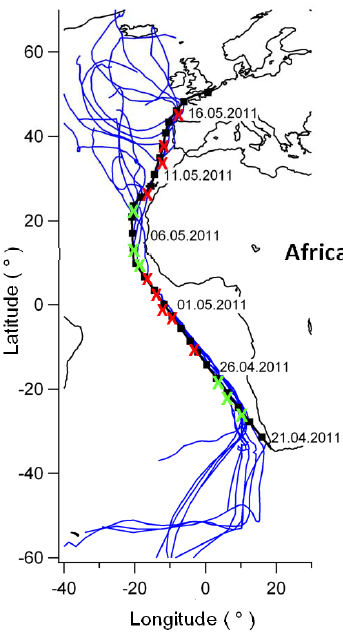
Fig. 1. Cruise plot including seawater sampling (red crosses), si- 720 multaneous seawater and aerosol particle sampling (green crosses) and backwards trajectories (blue